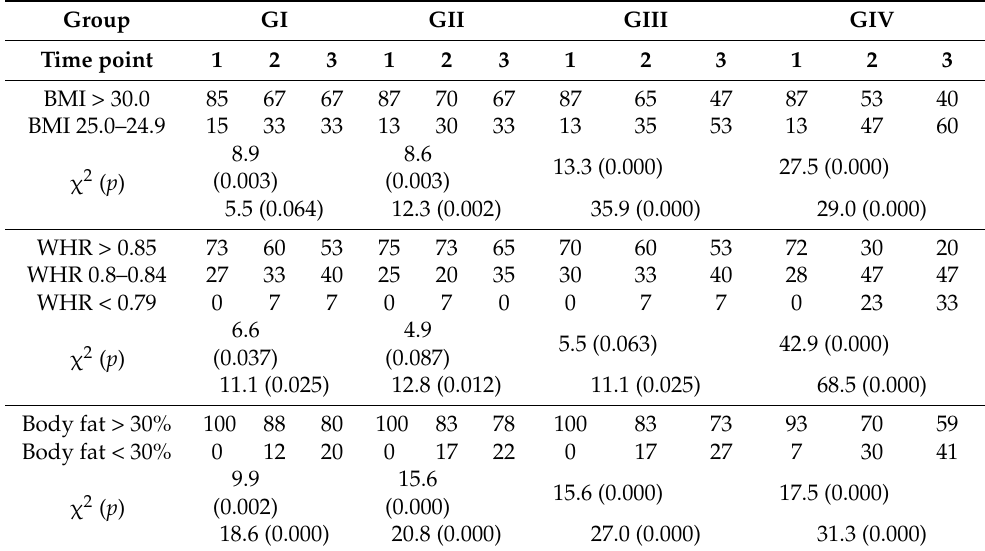
Table 4. Percentage distributions of the results for time points of the study and analysed